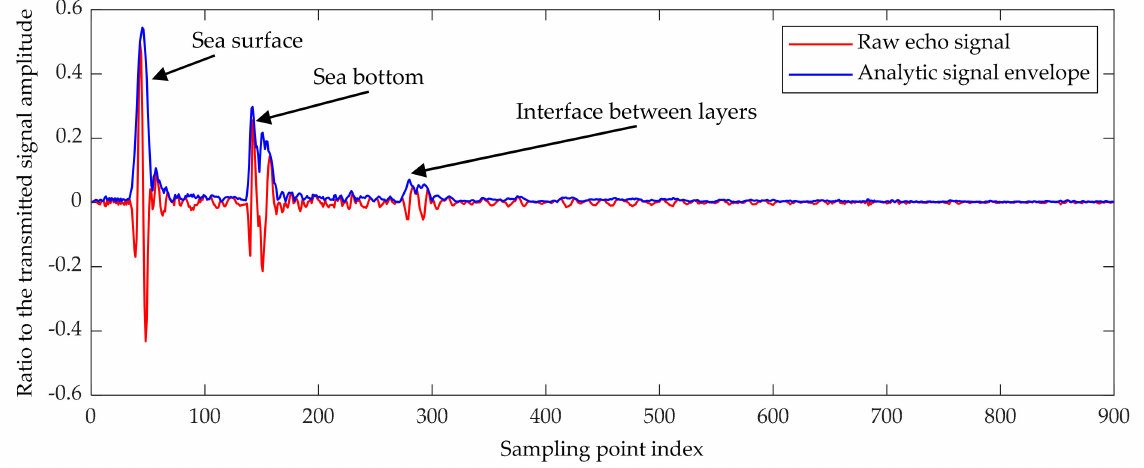
Figure 4. A ping of raw echo data recorded by SBP and the analytic signal